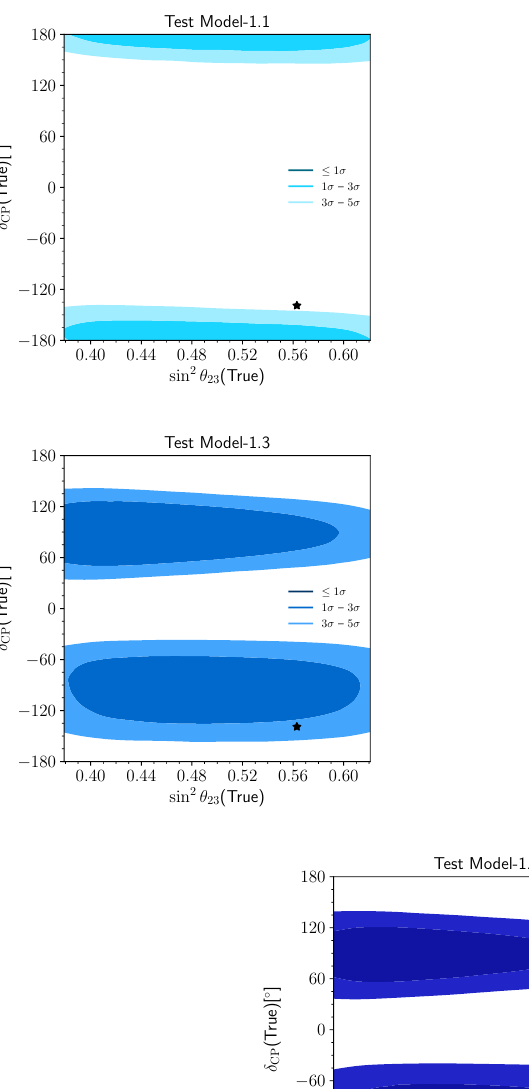
= 7 : 39 10 (cid:0) 5 eV 2 , and (cid:1) m 2 = 21 31 (cid:1)